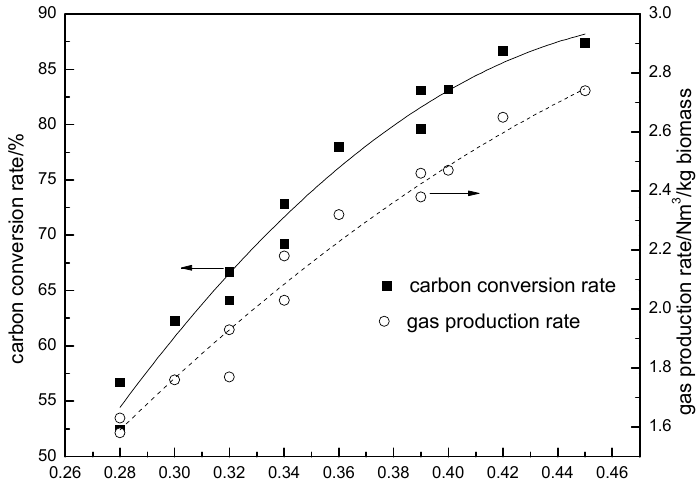
Figure 12. Carbon conversion rate and gas production rate.